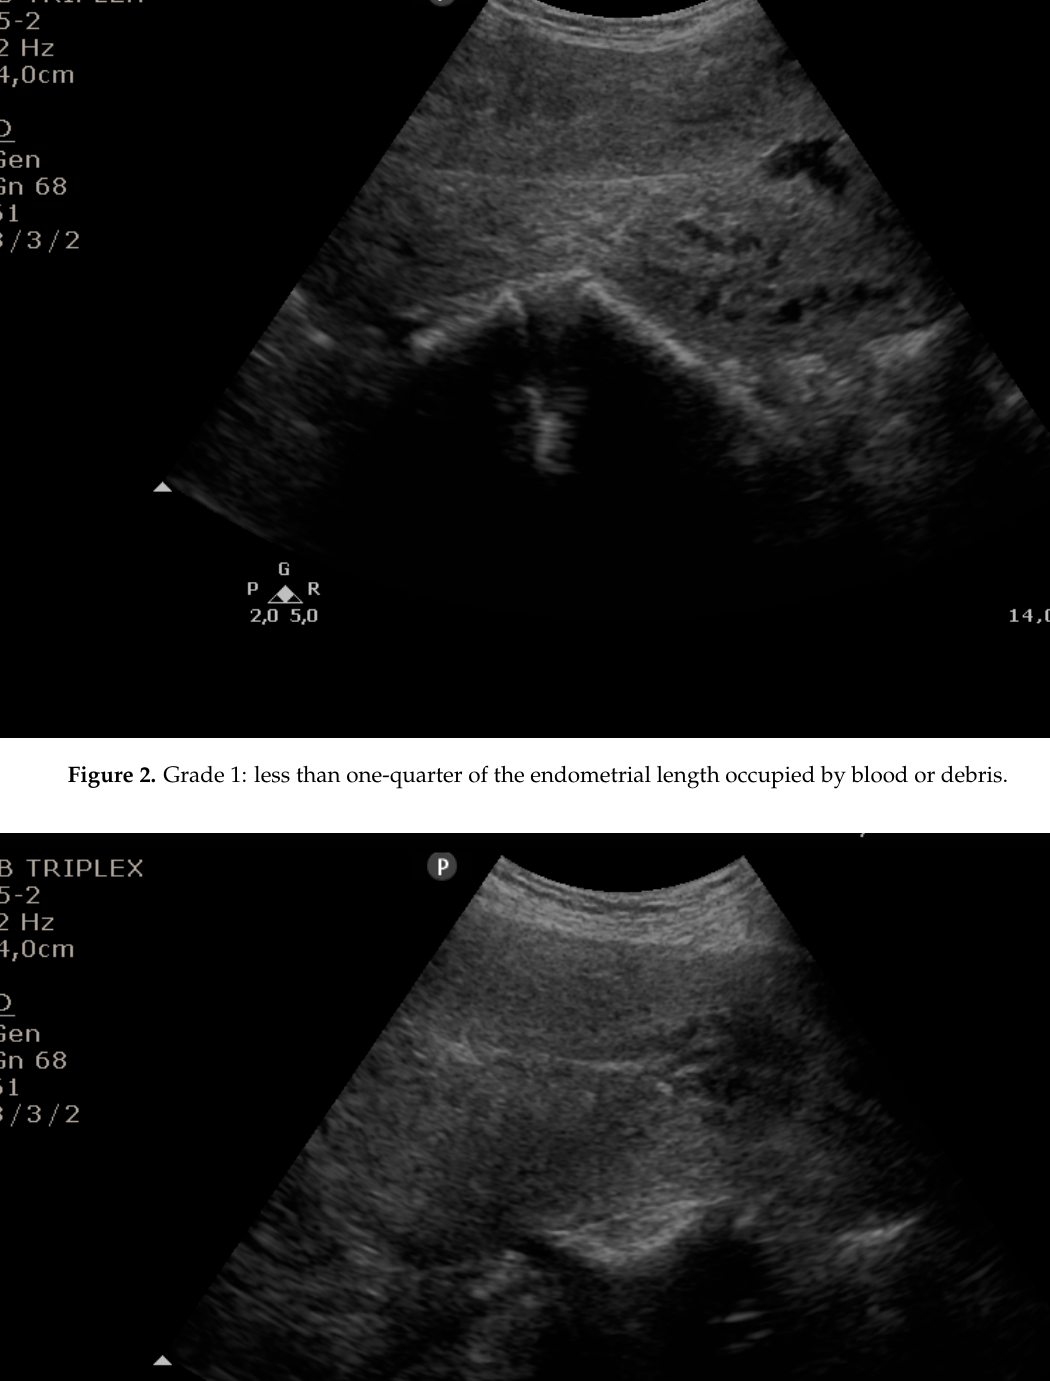
Figure 1. Grade 0: no blood or debris in the uterine cavity.